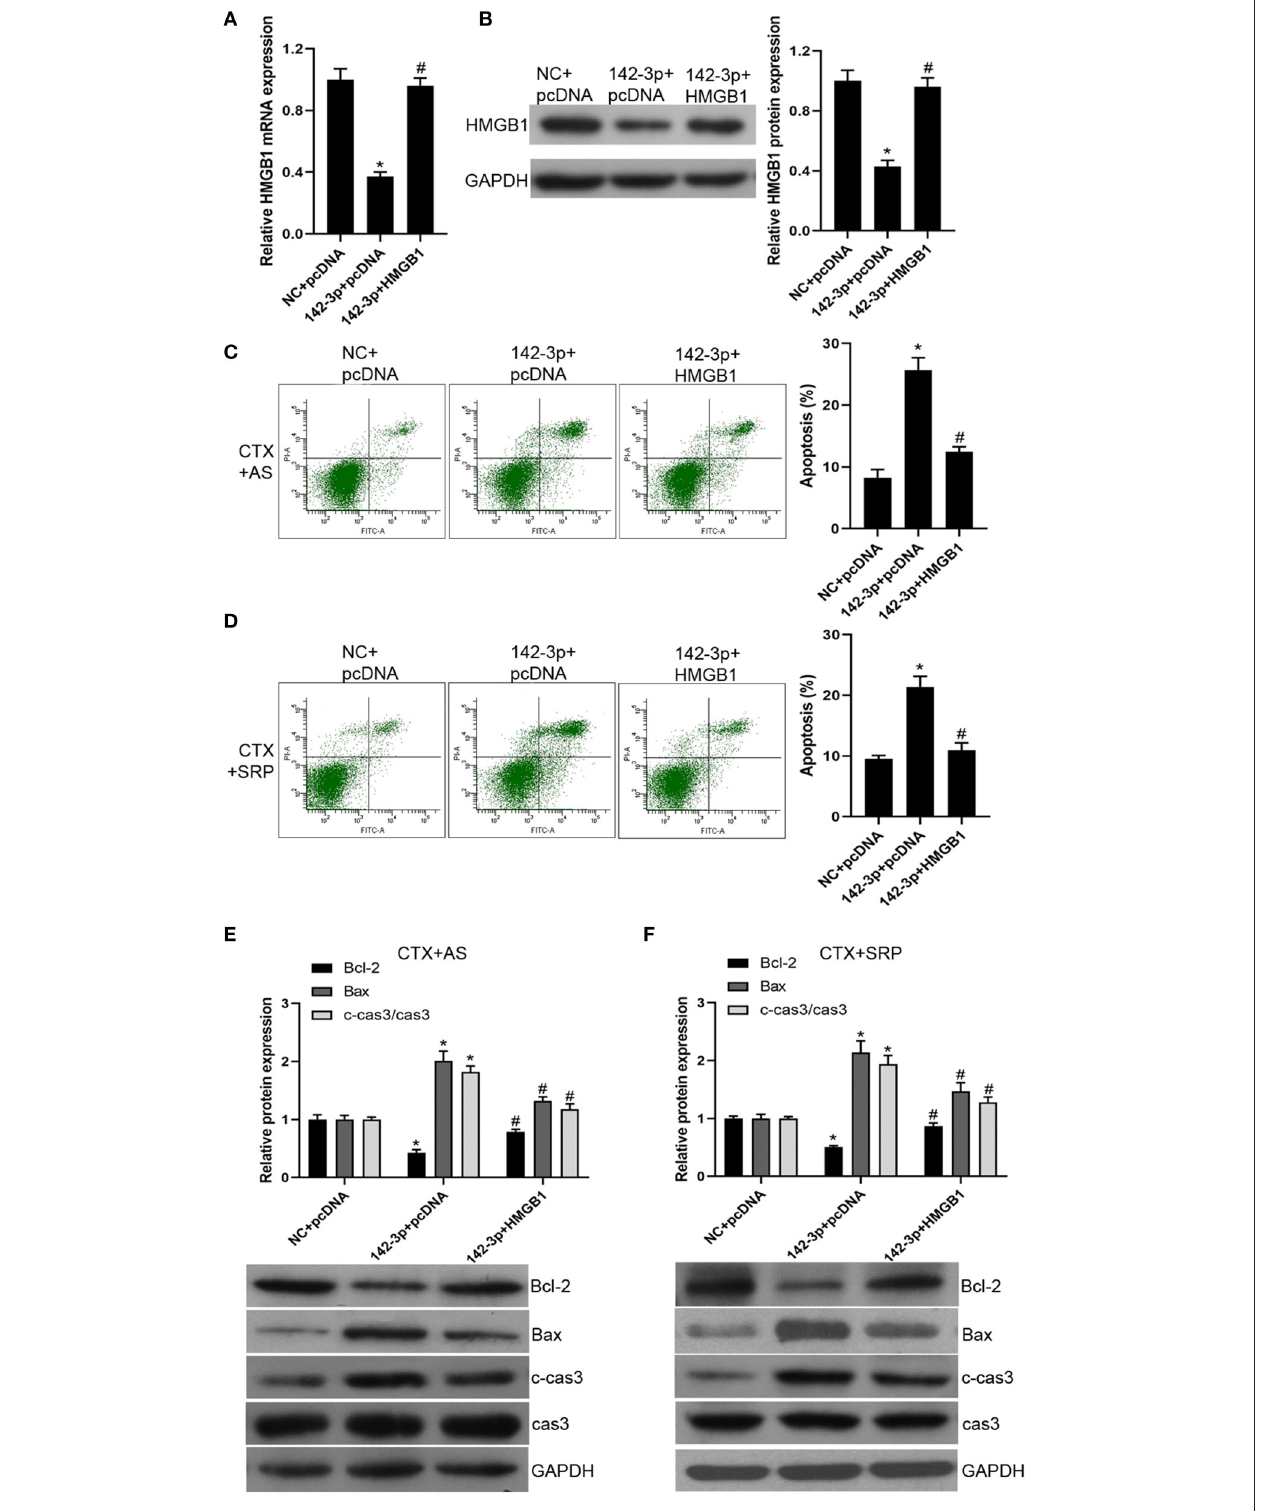
FIGURE 4 | Over-expression of HMGB1 reversed the effect of miR-142-3p on apoptosis in bone marrow hematopoietic stem cells. (A,B) After co-transfection with miR-142-3p mimic and pcDNA-HMGB1, HMGB1 mRNA and protein levels were determined by RT-qPCR and Western blot, respectively. (C,D) Cell apoptosis was detected by Annexin V-PI staining under CTX + AS (C) or CTX + SRP (D) condition. (E,F) Protein expressions of Bcl-2, Bax, and c-cas3/cas3 were determined by Western blot. Cell apoptosis was detected by Annexin V-PI staining under CTX + AS (E) or CTX + SRP (F) condition. * P < 0.05 vs. NC + pcDNA group; # P < 0.05 vs. 142-3p + pcDNA group; n =